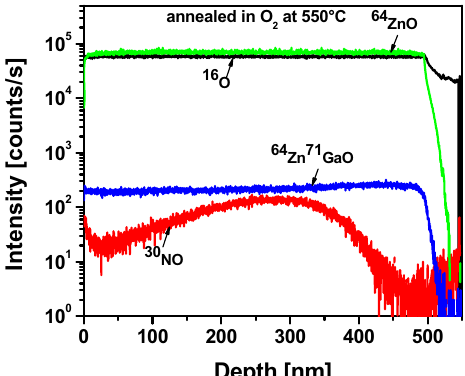
Fig. 6. SIMS depth profiles of N-implanted ZnO:Ga films an- nealed in O 2 at 550 ◦ C for 30